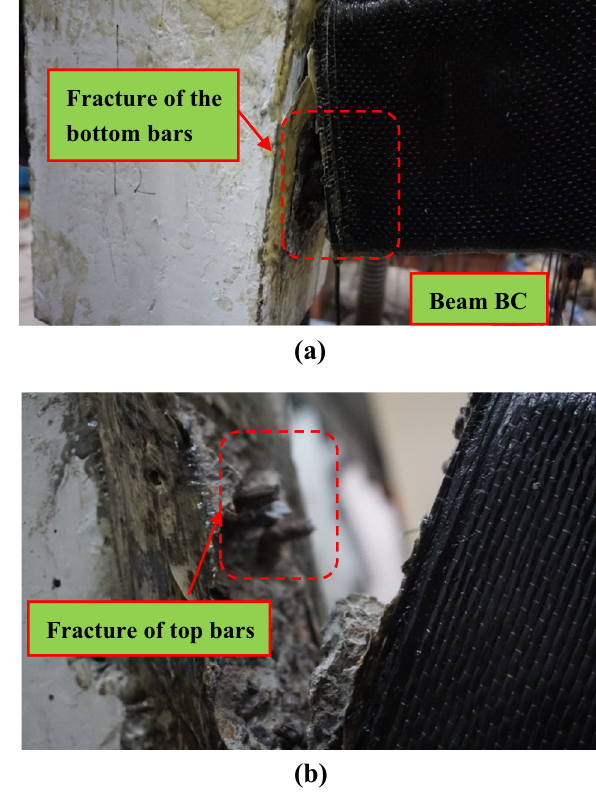
Figure 7: Crack pattern and failure mode of S2: ( a ) at the middle joint and ( b ) at the beam end near column